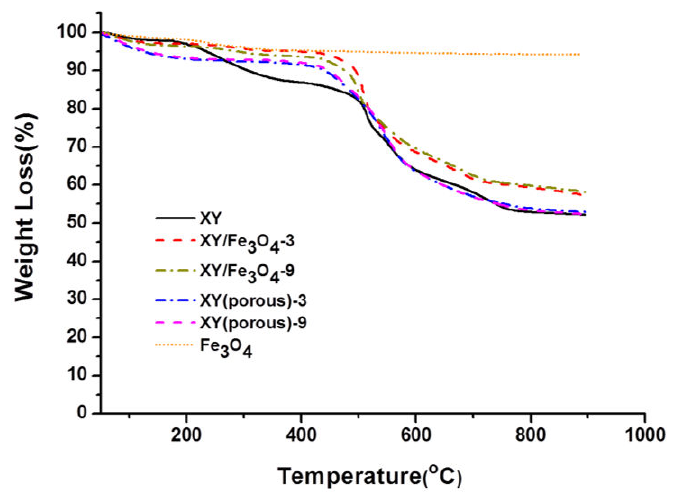
Figure 8. Thermogravimetric analysis (TGA) curves of Fe 3 O 4 nanoparticles, and bare XY, composite, and porous membranes.